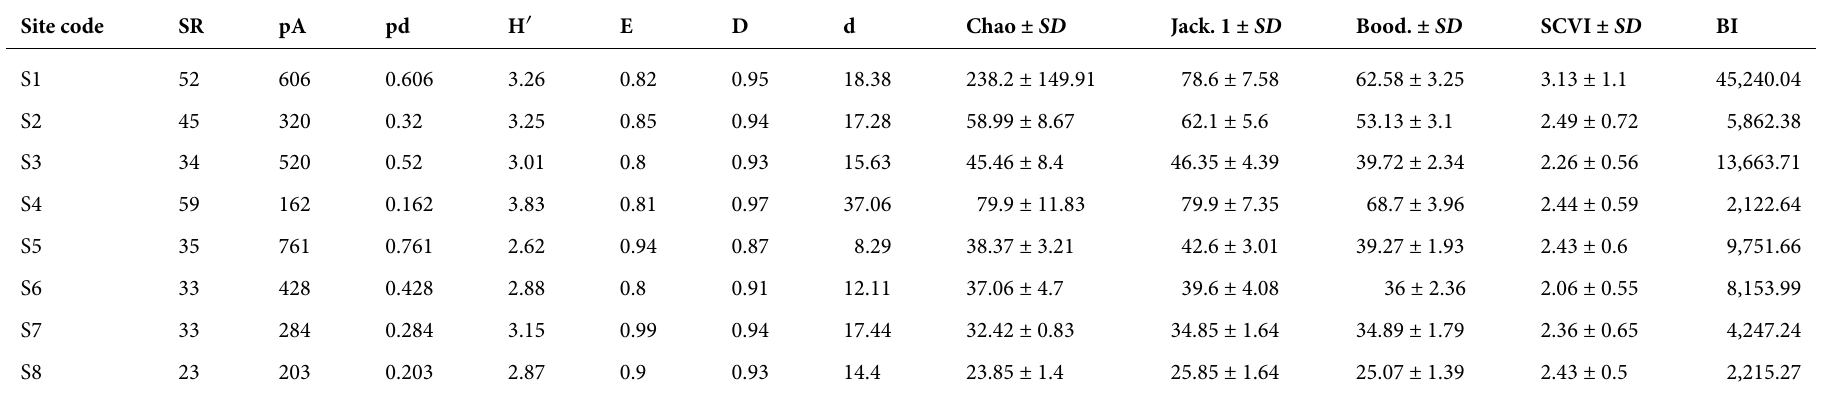
Table 2 Results of biodiversity indices. Site